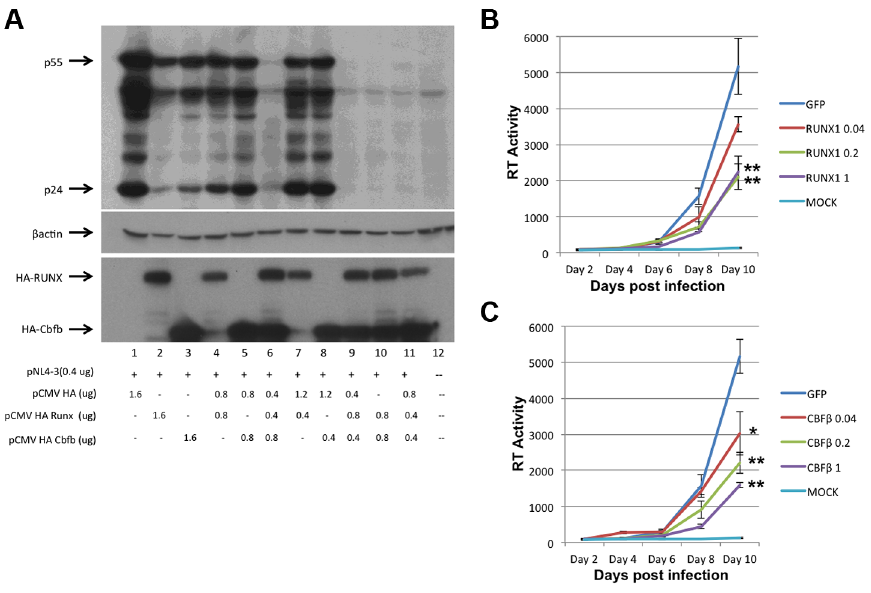
Figure 1. RUNX1 and CBF- b are capable of repressing HIV-1 replication. A ) HeLa cells were transfected with the pNL4-3 proviral plasmid and the indicated amounts of HA-tagged RUNX1 or CBF- b expression vectors. Forty-eight hours post transfection cells were harvested, protein extracts were prepared and extracts were Western blotted for p24 and p55 Gag using human immune serum (upper panel), b -actin (middle panel) or HA (lower panel). Jurkat T-cells were transfected with1 ug of pMAXGFP or 0.04, 0.2 or 1 ug of B ) pRUNX1 or C ) pCBF- b and infected with NL4-3 twenty- four hours post transfection. Viral replication was followed by RT at days 2, 4, 6, 8 and 10 post infection.